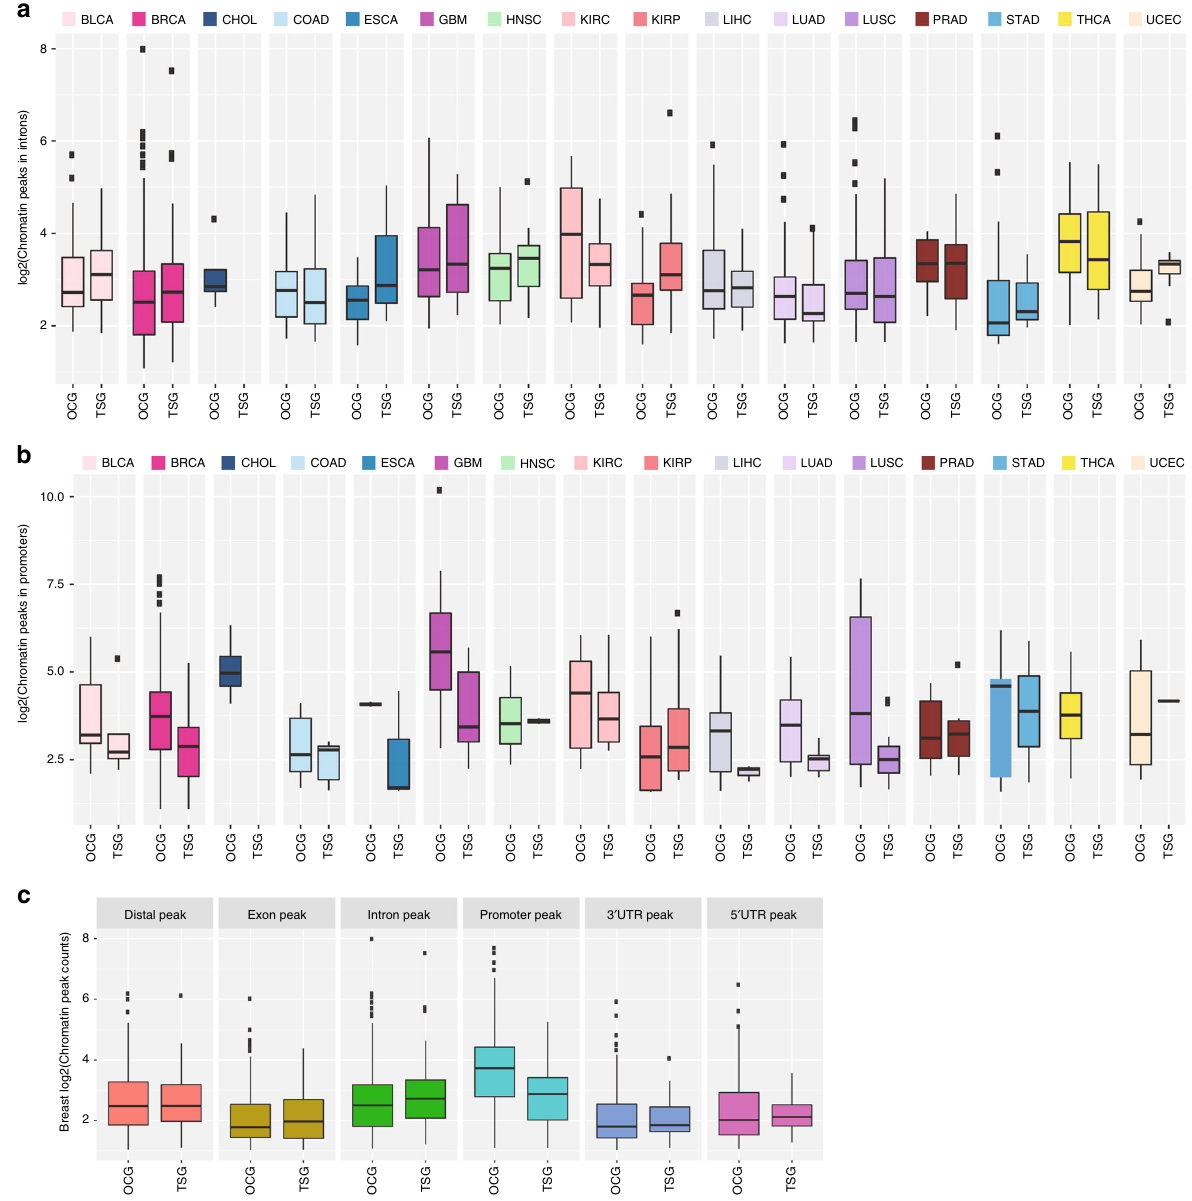
Fig. 3 Chromatin accessibility landscape of oncogenic mediators. a log2 (chromatin peaks in promoters) for tumor suppressor and oncogenes detected in Pan-Cancer study, b boxplot showing log2 (chromatin peaks in introns), and c breast cancer log2 (chromatin peaks